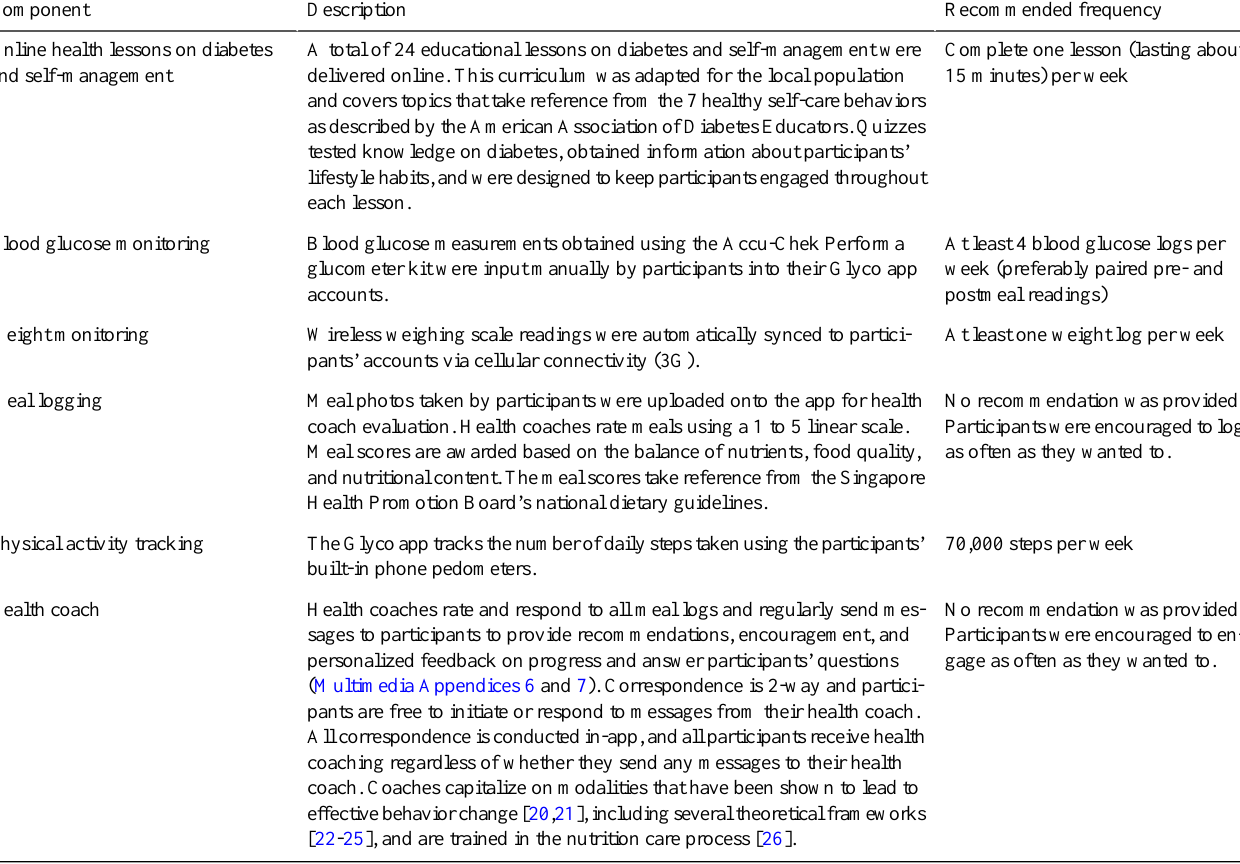
Table 1. Description of GlycoLeap program components and recommendations for